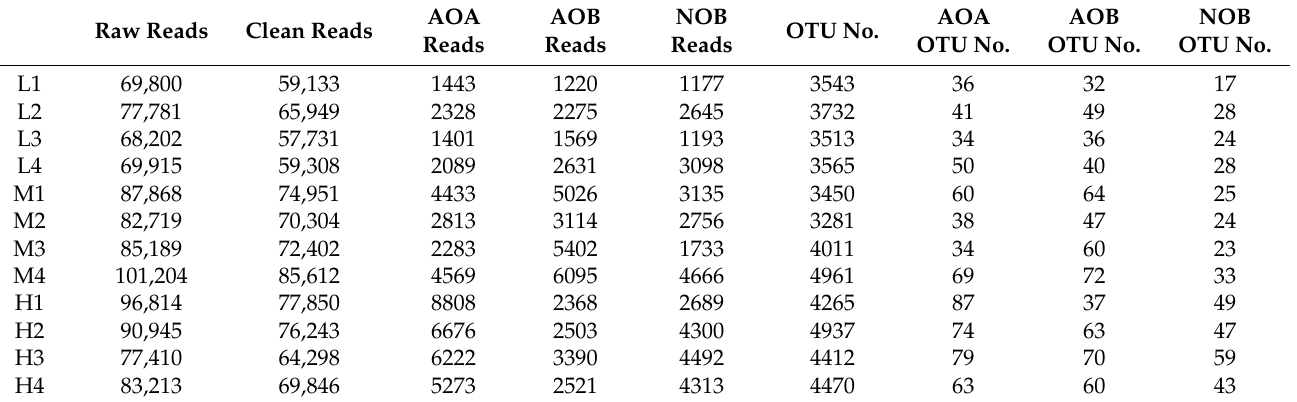
Table 4. A general summary of the results of next-generation sequencing.